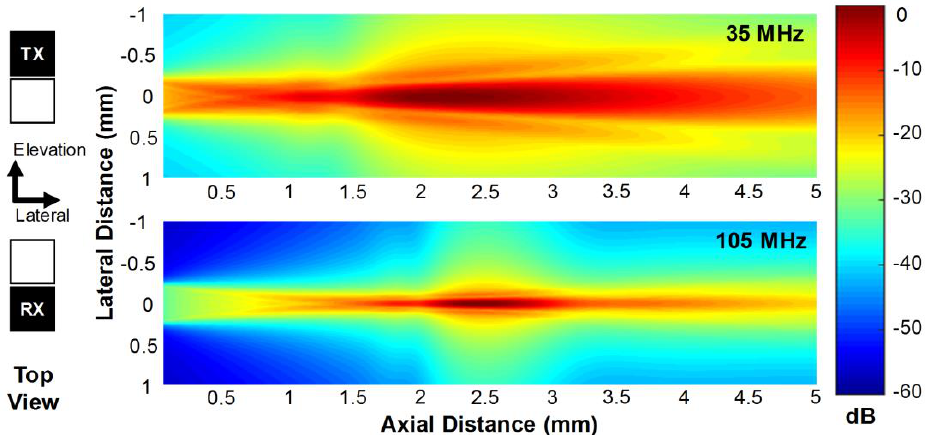
Figure 2. Transmit (TX) beam profile generated by the 35-MHz element (upper) and receive (RX) beam profile by the 105-MHz element (lower), which were obtained by the Field II simulation.